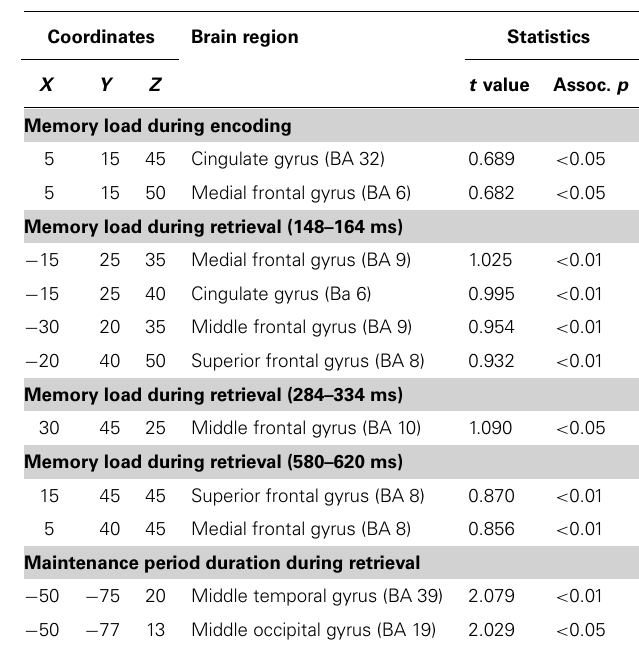
Table 2 |Voxels showing maximal differences in activation between